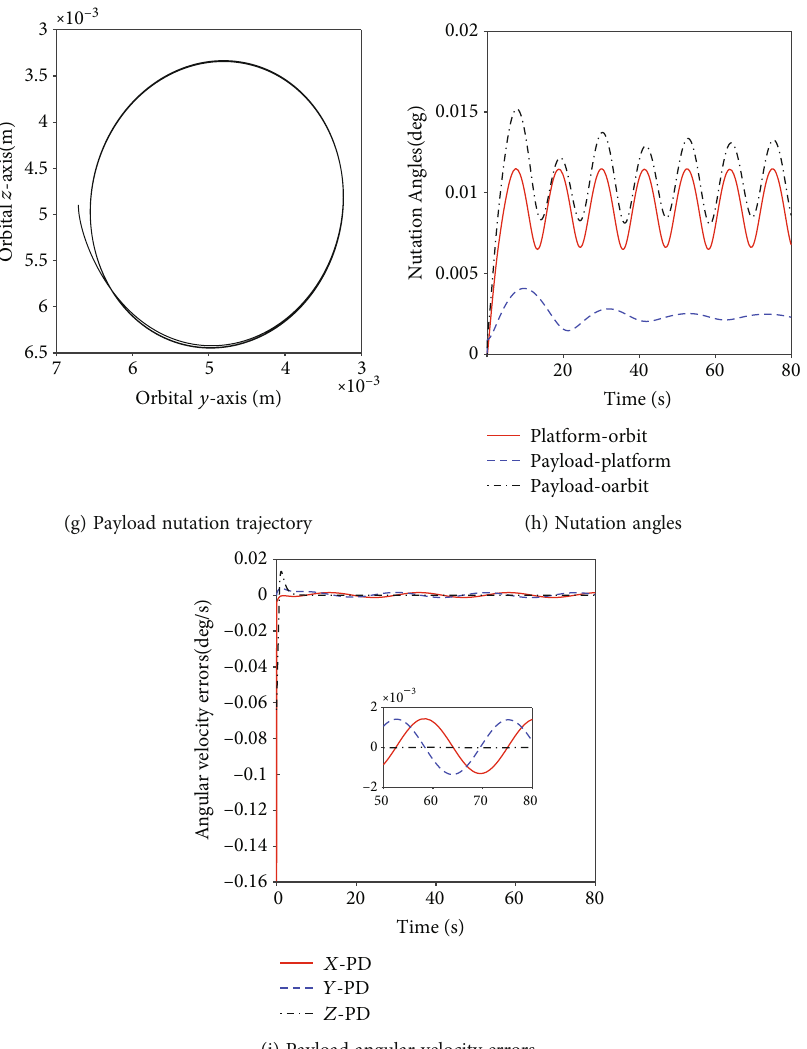
Figure 8: RPS system attitude results under the lumped disturbance and